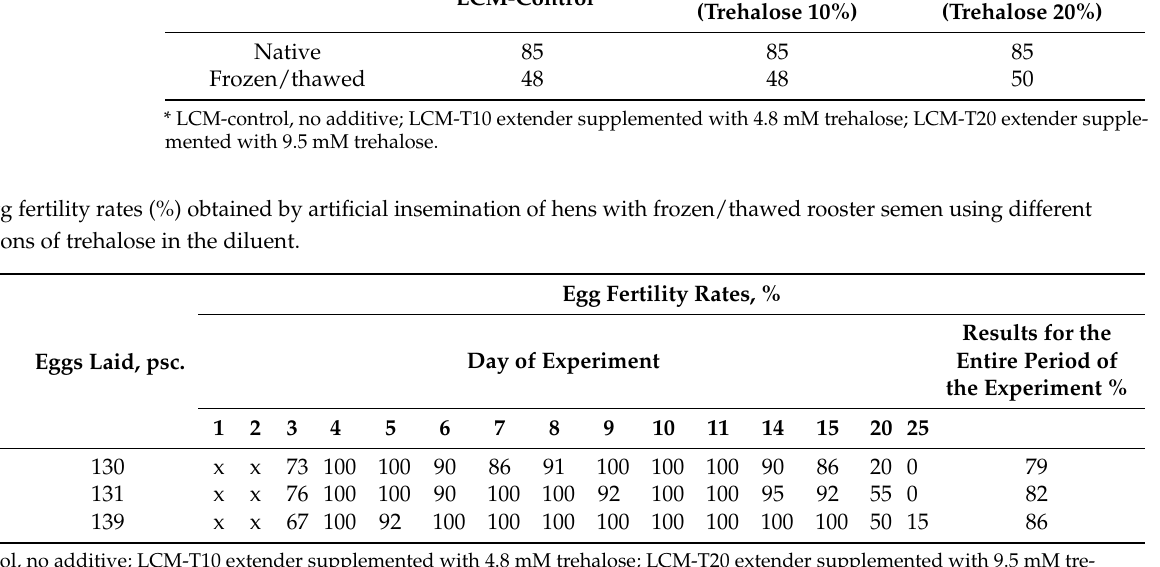
Table 2. Indicators of the total motility of rooster semen (%) depending on the diluent used for cry- opreservation.